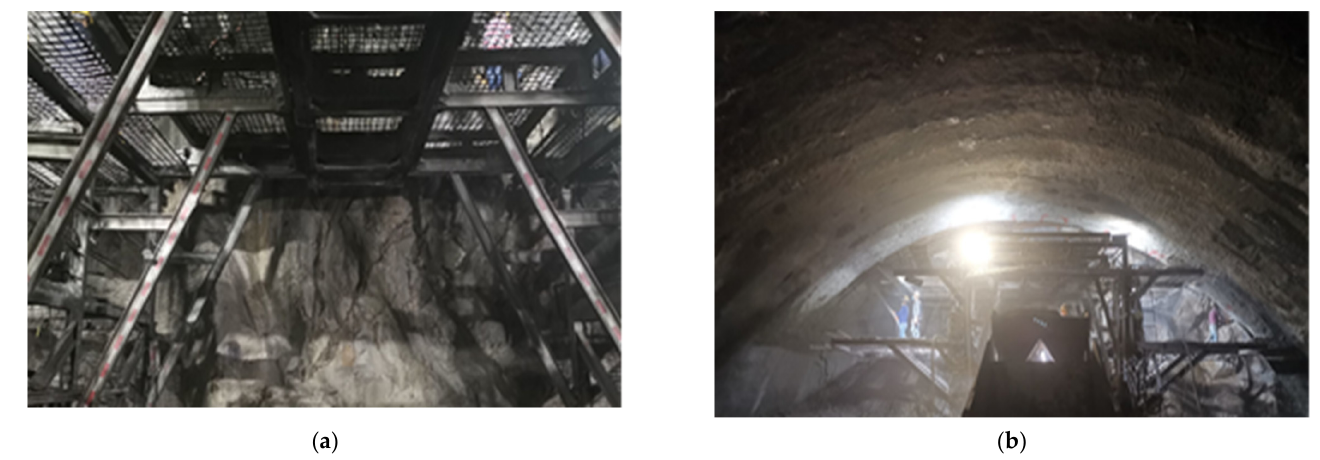
Figure 7. Situation of the working face surrounding rock: ( a ) large mileage direction; ( b ) small mileage direction.